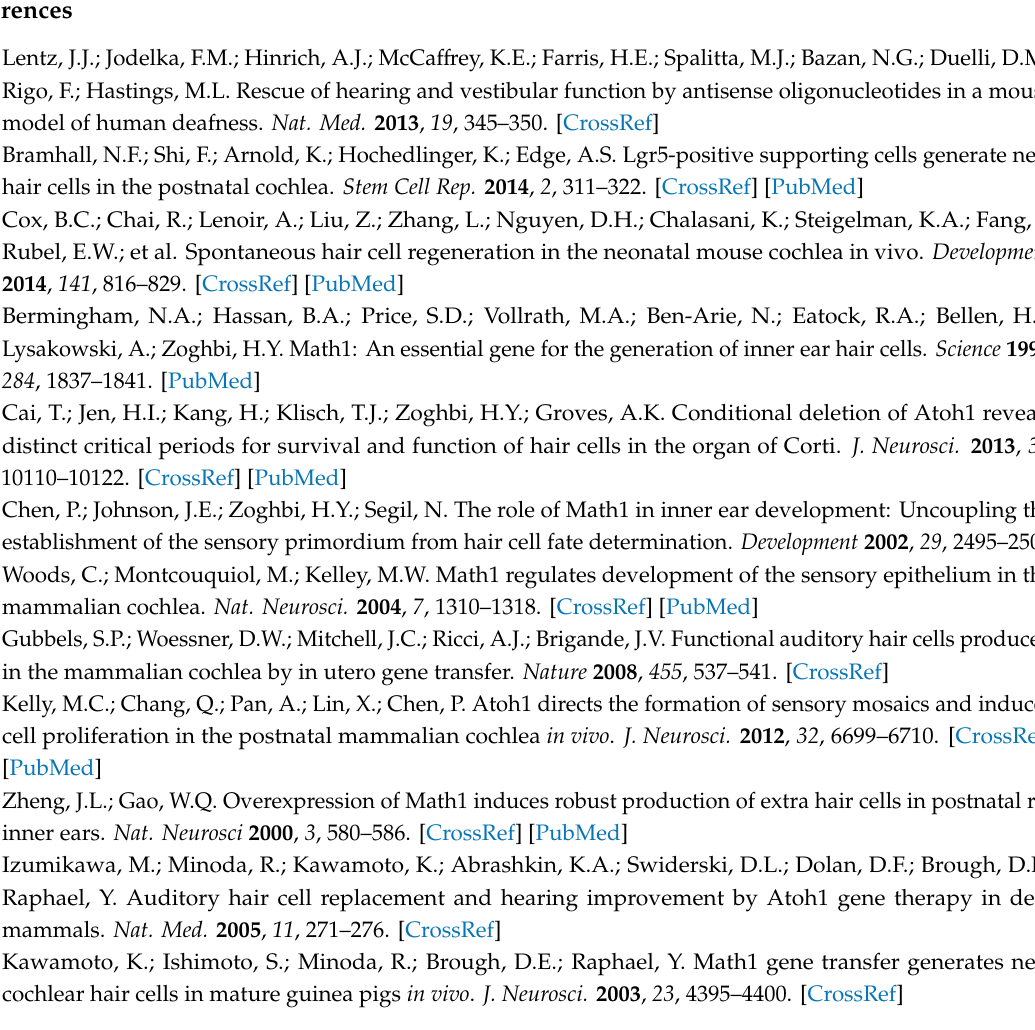
Table S1: Predicted sgRNA o ff -target sites in BEM line. Table S2: The primers used in o ff -target examination in BEM line. Table S3: The primers used in qRT-PCR. Table S4: Downregulated hair cell-specific genes in BEM derivatives. Table S5: Upregulated inner ear non-sensory cell-specific genes in BEM derivatives. Figure S1: O ff -target examination in BEM